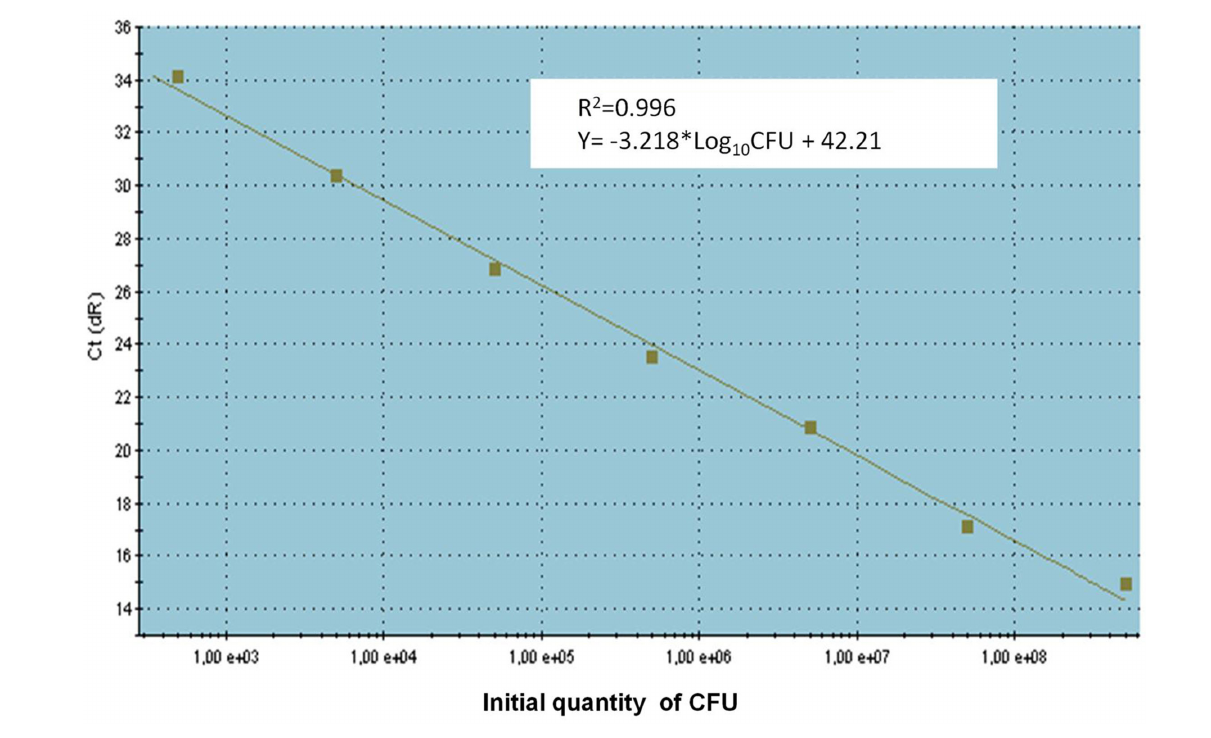
FIGURE 2 |The standard curve for absolute quantification of C. coli in swine manure. Standard curves produced from 10-fold serial dilutions ranging from 1 × 10 2 to 1 × 10 8 CFU/ml swine manure sample of C. coli (CCUG 11283), showing the relationship between C t -values and CFU/ml for qPCR assays. C t , cycle